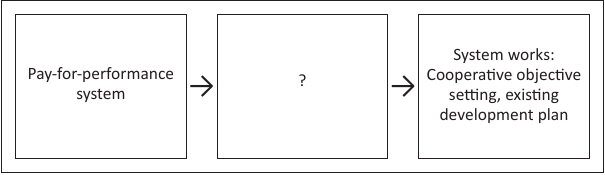
FIGURE 1: Diagram of an effective pay-for-performance